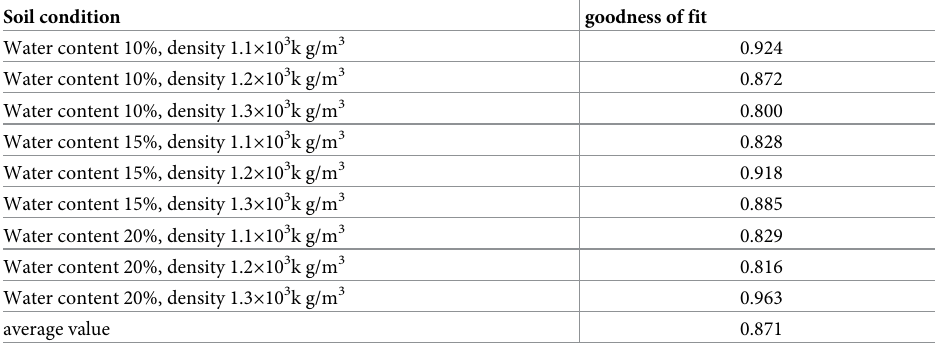
Table 2. Goodness of fit of theoretical resistance